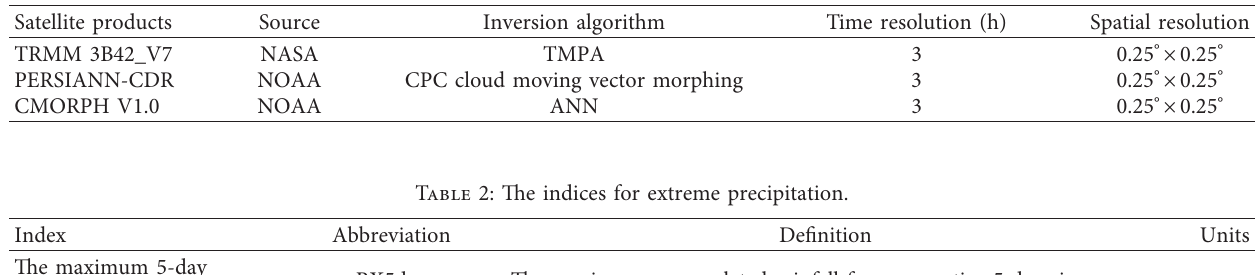
Figure 1: Distribution of national meteorological stations in the Three Gorges Reservoir area. Table 1: Summary of the three satellite products.